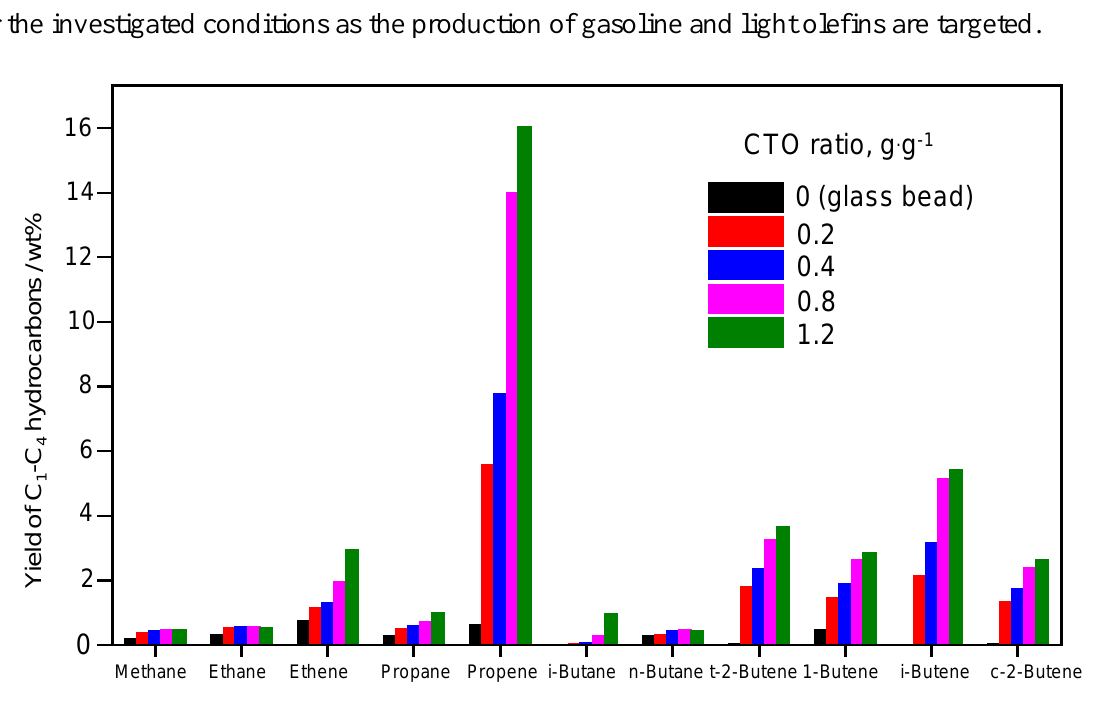
Figure 1. Yields of C 1 –C 4 hydrocarbons in the cracking of triolein under different severities by varying the CTO ratio from 0 (glass beads) to 1.2 g∙g −1 at 550